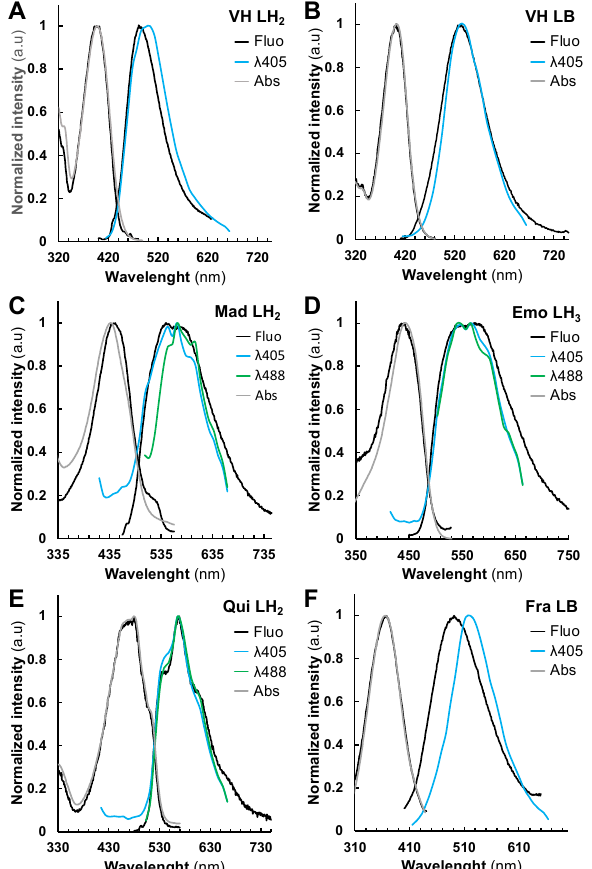
Figure 2. Normalized fluorescence excitation/emission and absorption spectra of studied compounds. ( A ) vismione H VH (neutral LH 2 species) and ( B ) (boron complex LB species), ( C ) quinizarin Qui (neutral LH 2 species), ( D ) emodin Emo (neutral LH 3 species), ( E ) madagascine Mad (neutral LH 2 species), ( F ) fraxetin Fra (boron complex LB species) in saline ethanolic solutions. Excitation and emission spectra obtained from the spectrofluorimetric analysis (black), absorption spectra obtained from the UV-Vis. analysis (grey), and SImaging at λ 405 (blue) and/or λ 488 (green)